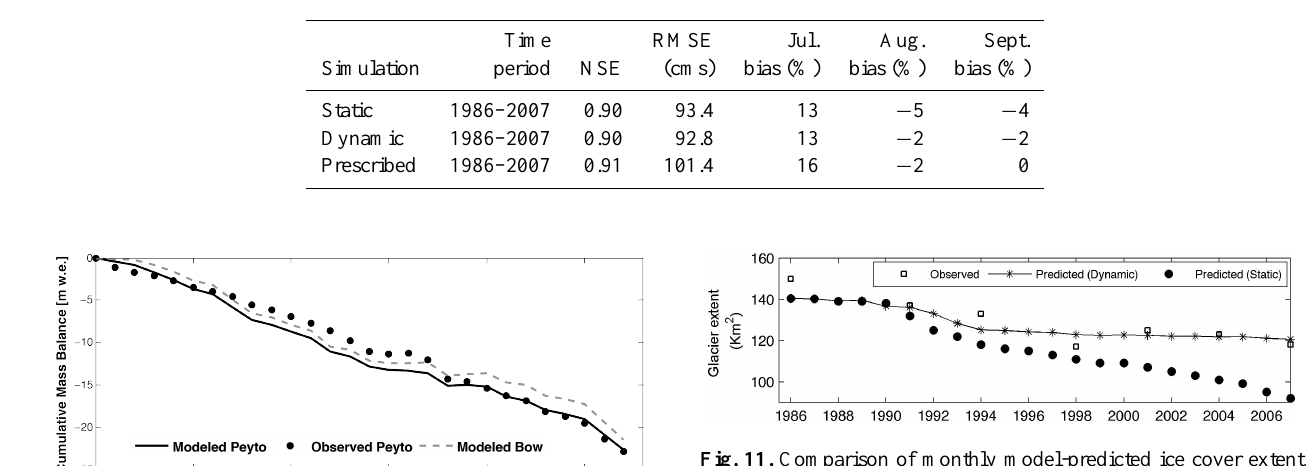
Table 3. Model performance statistics for prediction of monthly mean streamflow for different model configurations.